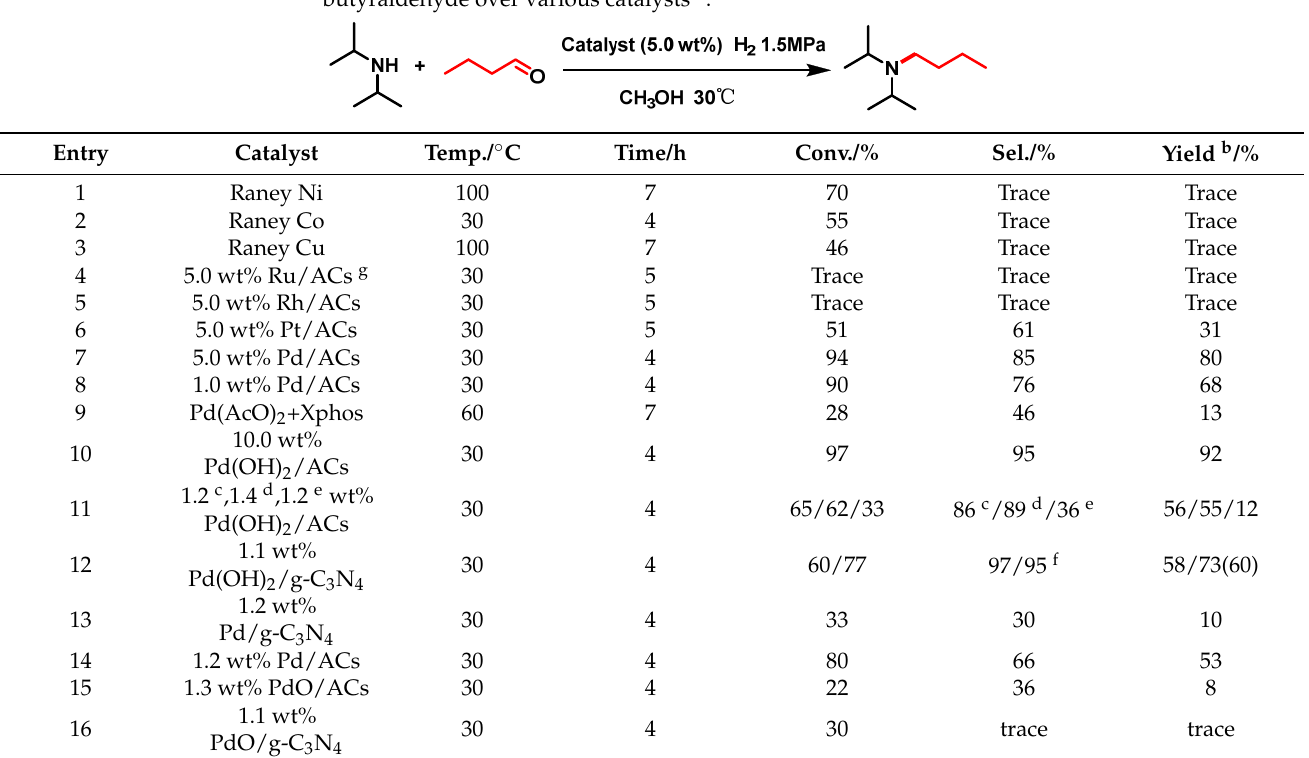
Table 1. Comparisons of the catalytic performance for reductive amination of diisopropylamine with butyraldehyde over various catalysts a .